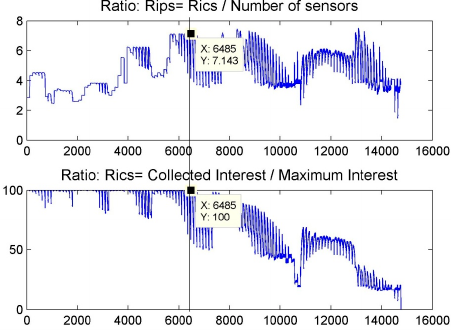
Figure 19. Ratio Rips &Ratio Rics “Scenario 2”.